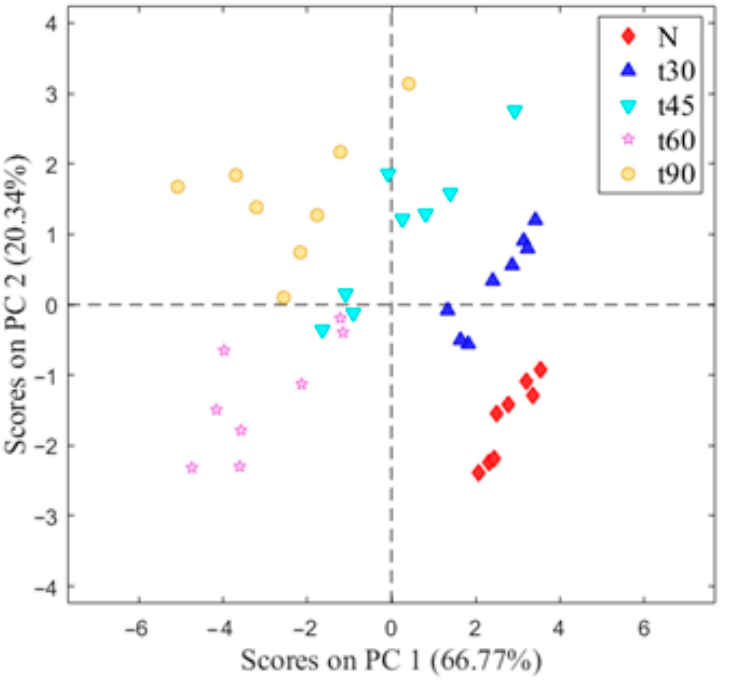
Figure 3. Score plot of the PCA analysis for oils extracted from almonds subjected to different thermal treatments before oil extraction.